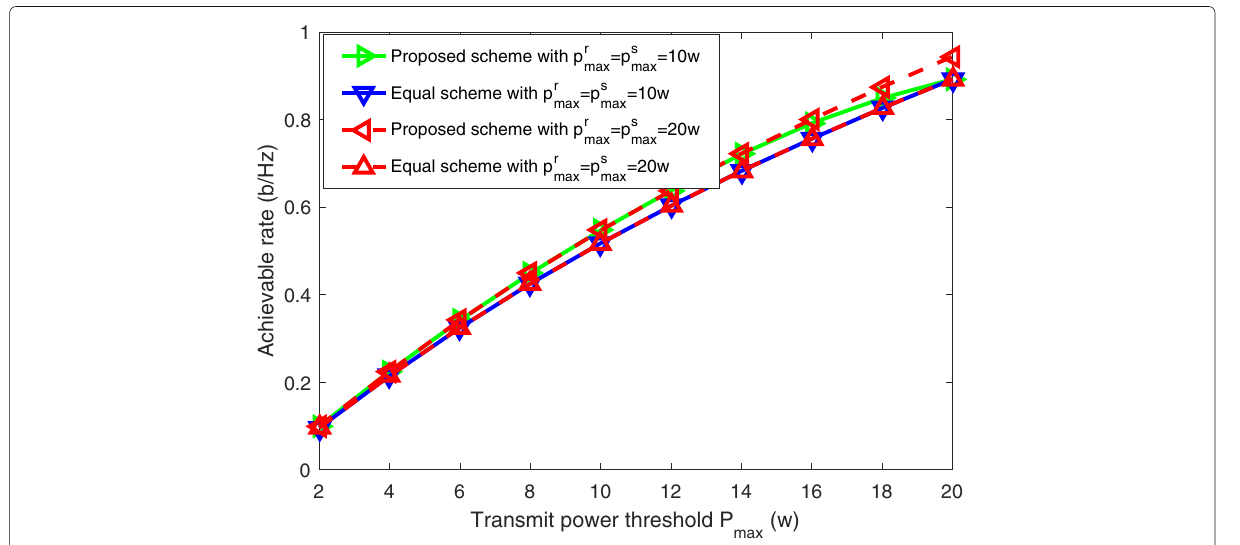
Fig. 2 The system achievable rate with the increasing total transmit power threshold